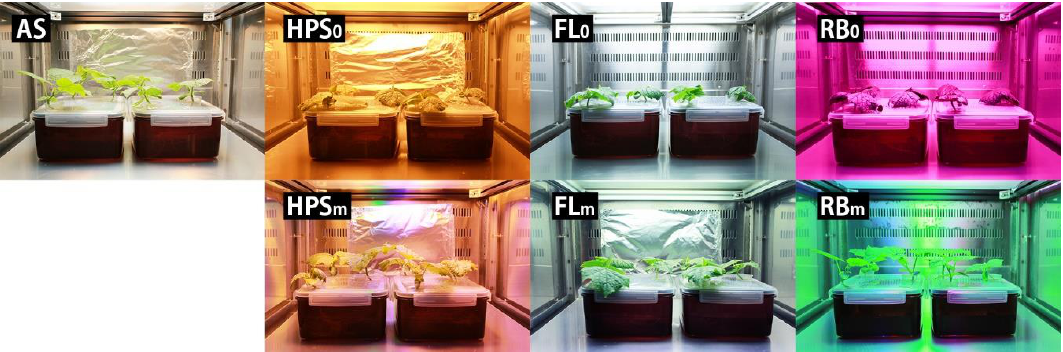
Figure 3. Visual appearance of each treatment and cucumber plants at 7 days after transplanting. See 2.4 for treatments.